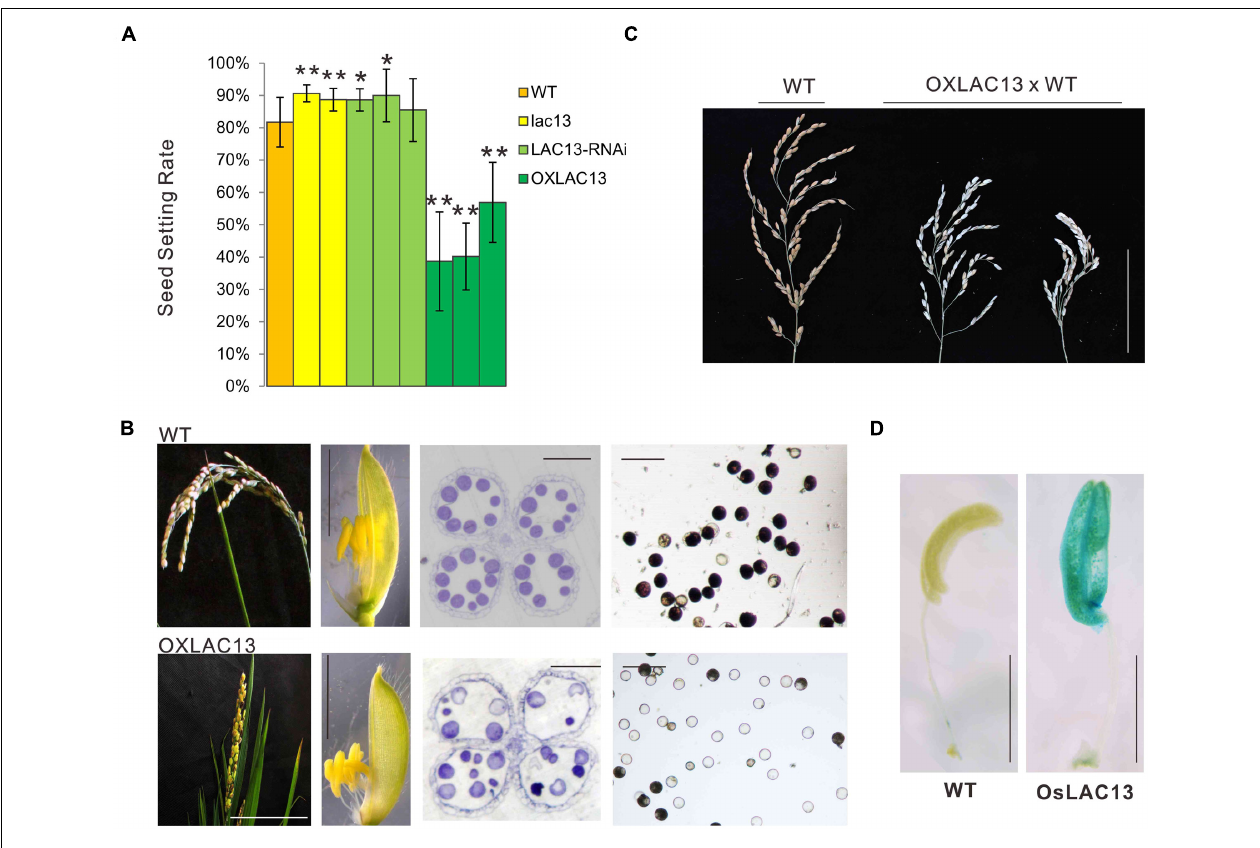
FIGURE 1 | OsLAC13 regulates seed setting rate and male reproductive organogenesis. (A) The seed setting rates of WT, OsLAC13 knock out ( lac13 ), OsLAC13 -RNAi, and OXLAC13 plants. Values are the means ± s. d. ( n = 40 plants). Significant differences were identified at the 5% ( ∗ ) and 1% ( ∗∗ ) probability levels using Student’s t -test. (B) The panicles of OXLAC13 plants crossed with WT plants. Scale bars, 10 cm. (C) The panicles (scale bars, 2.5 cm), the spikelet (scale bars, 4 mm), the transverse semithin sections of mature anthers (scale bars, 100 µ m) and the mature pollen grains stained for starch with I 2 -KI (scale bars, 100 µ m) of WT and OXLAC13 plants from the left panels to the right panels. (D) Expression patterns of OsLAC13 by GUS staining (Blue). Scale bars, 2